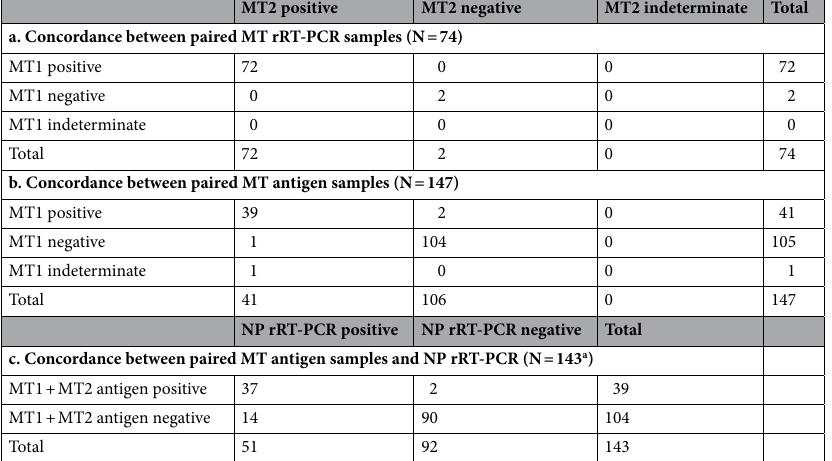
Table 2. Impact of repeated sample collection on test performance. a: McNemar’s test for agreement of positive/negative results: N/A No discordant pairs. a: Kappa coefficient (exact 95% CI): 1.00 (N/A). a: Overall agreement (exact 95% CI): 100% (N/A). b: McNemar’s test for agreement of positive/negative results: p = 0.56. b: Kappa coefficient (exact 95% CI): 0.95 (0.88–1.00). b: Overall agreement (exact 95% CI): 97%